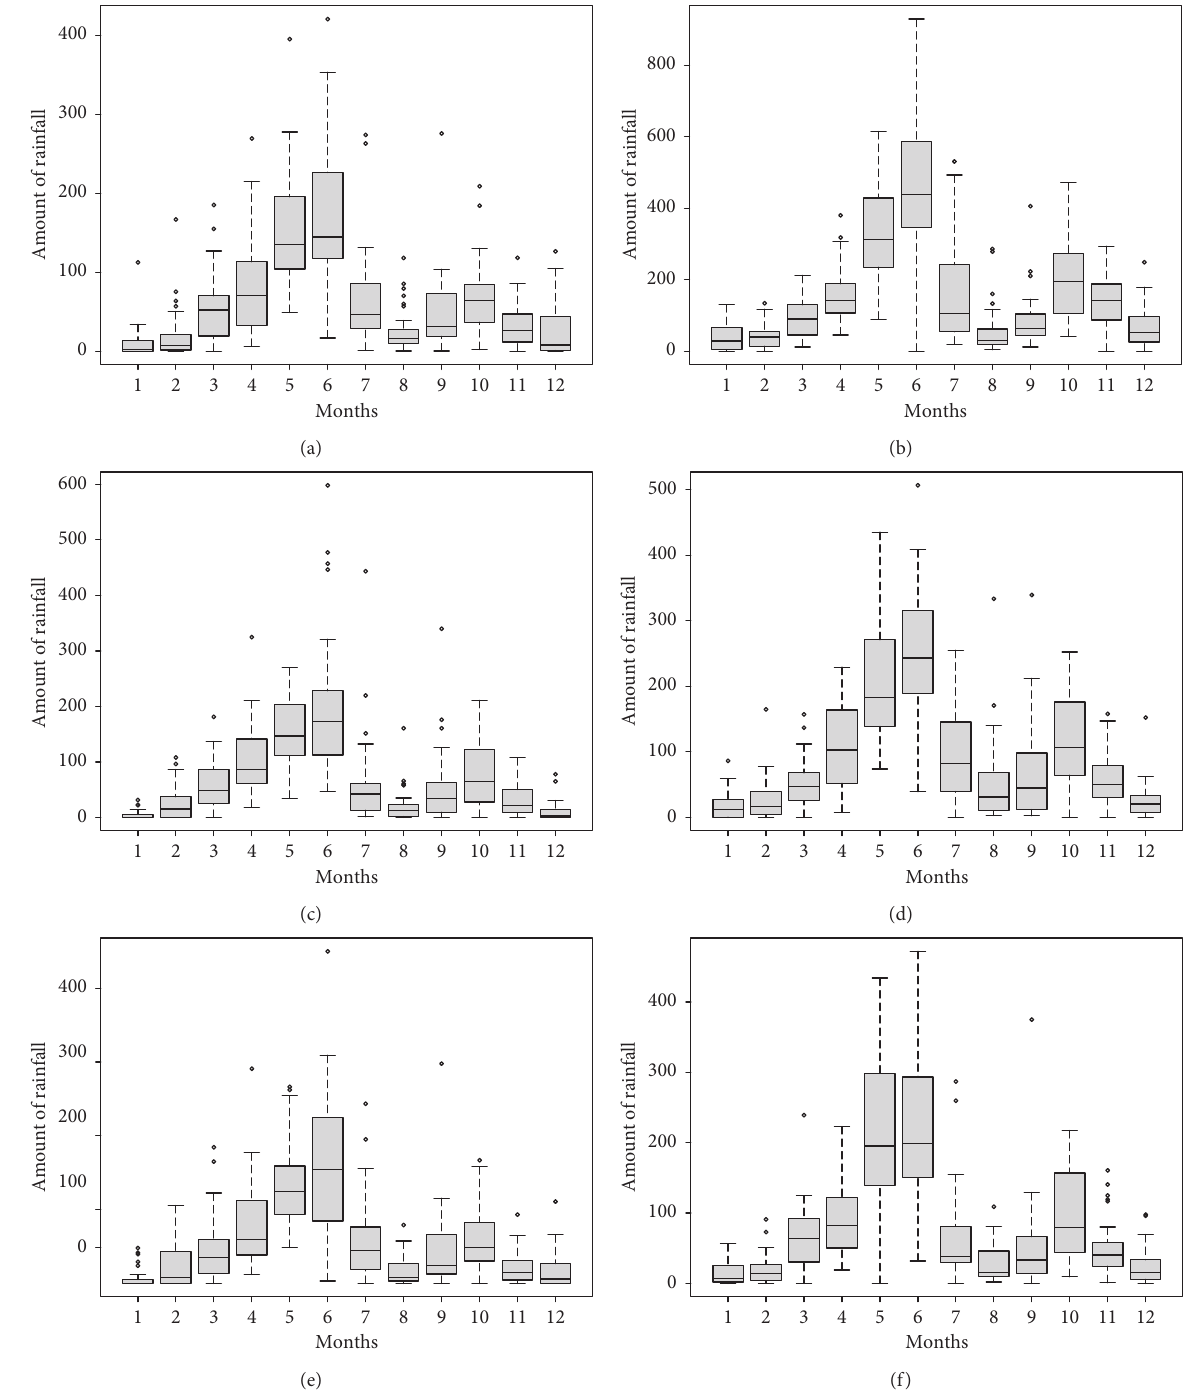
Figure 2: Boxplot showing monthly rainfall amount for (a) Accra, (b) Axim, (c) Ada, (d) Takoradi, (e) Tema, and (f) Saltpond mete- orological stations from 1980 to